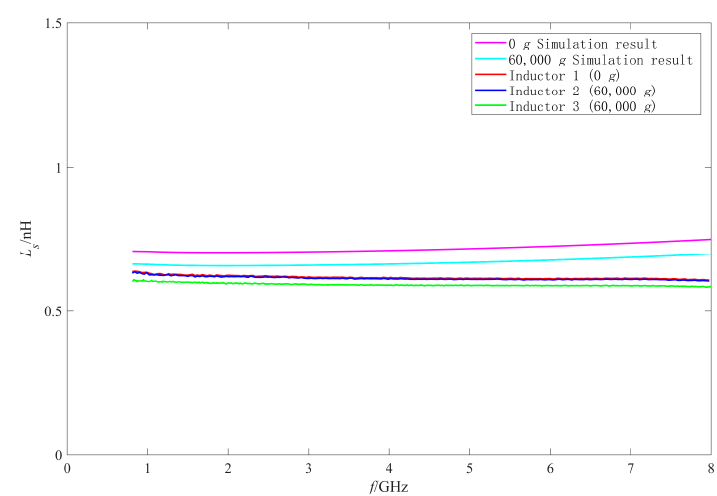
Figure 20. The measured and simulated L s of the intact inductors before and after shock test. Table 2. The measured and simulated 𝐶 (cid:3046) of the intact inductors before and after shock test. Shock Amplitude The Measured 𝑪 𝒔 /fF The Simulated 𝑪 𝒔 /fF 0 g